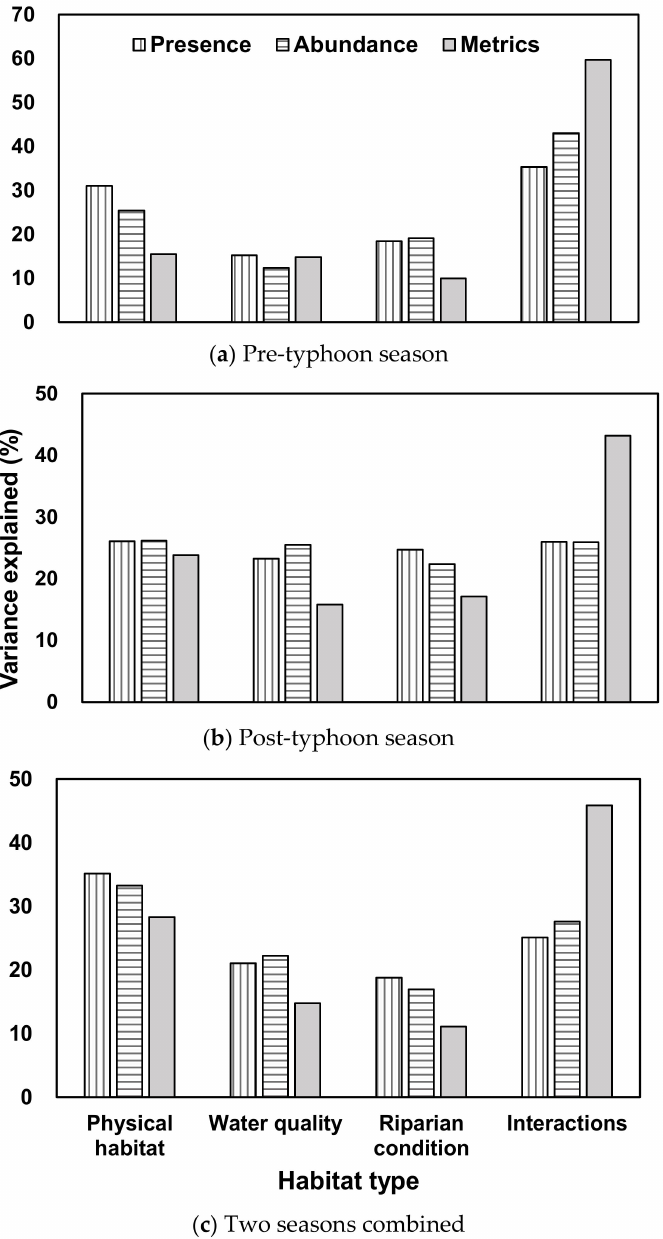
Figure 4. The percent of fish community variance was explained by physical habitats, water quality, riparian conditions, and interactions for three fish measures in ( a ) the pre-typhoon season, ( b ) the post-typhoon season, and ( c ) the two seasons